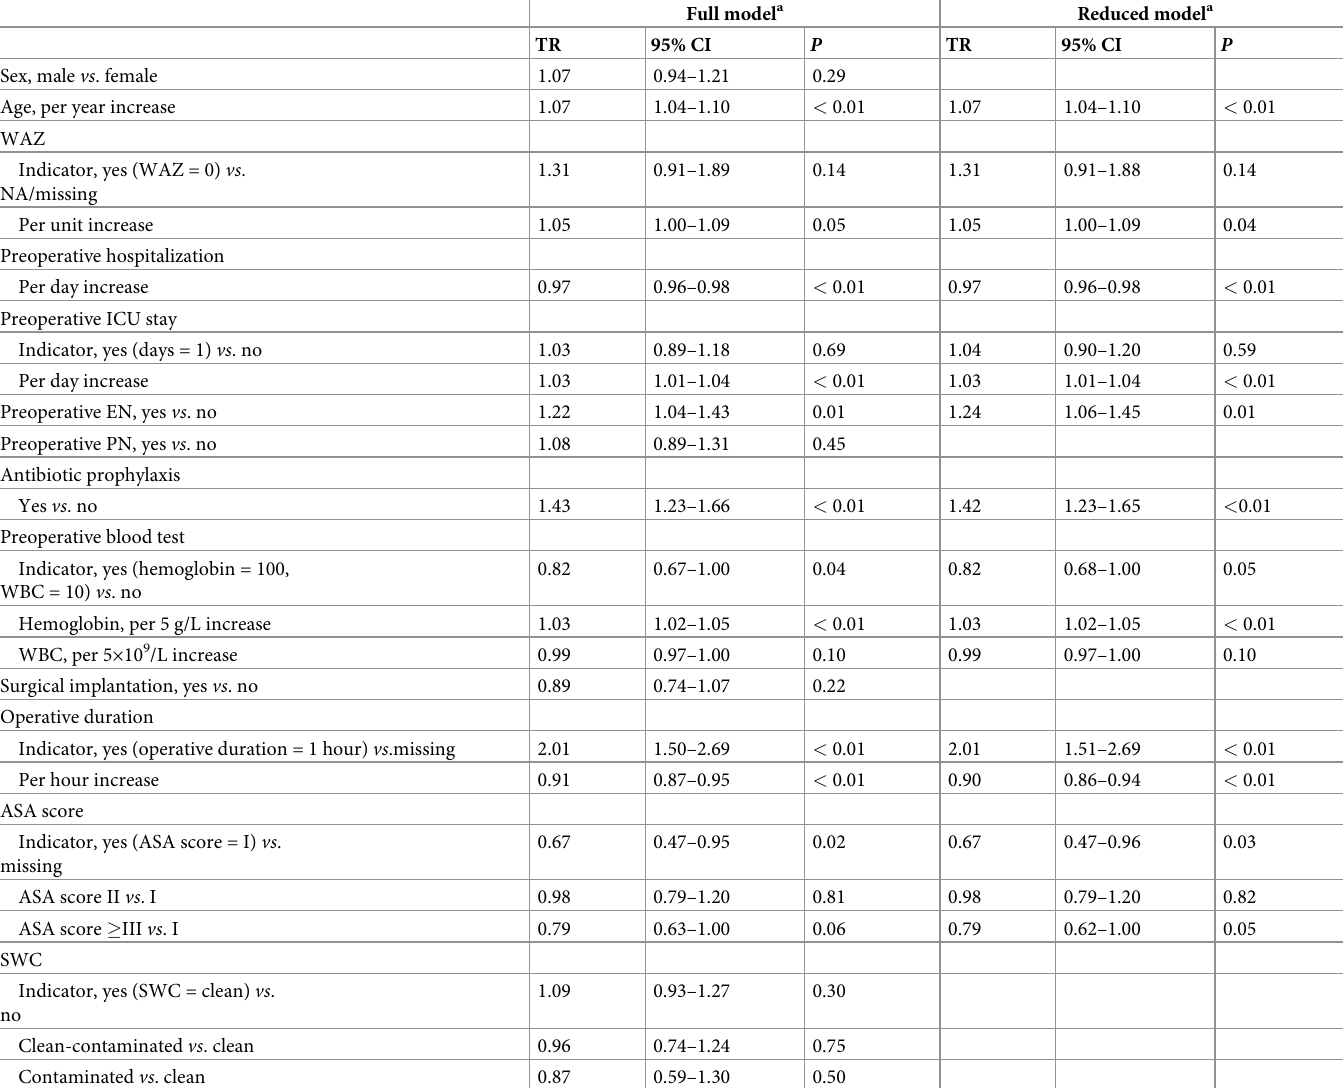
Table 3. Associations between baseline factors and the development of postoperative NIs in multivariable AFT log-normal models, the Guangzhou Women and Children’s Medical Center,